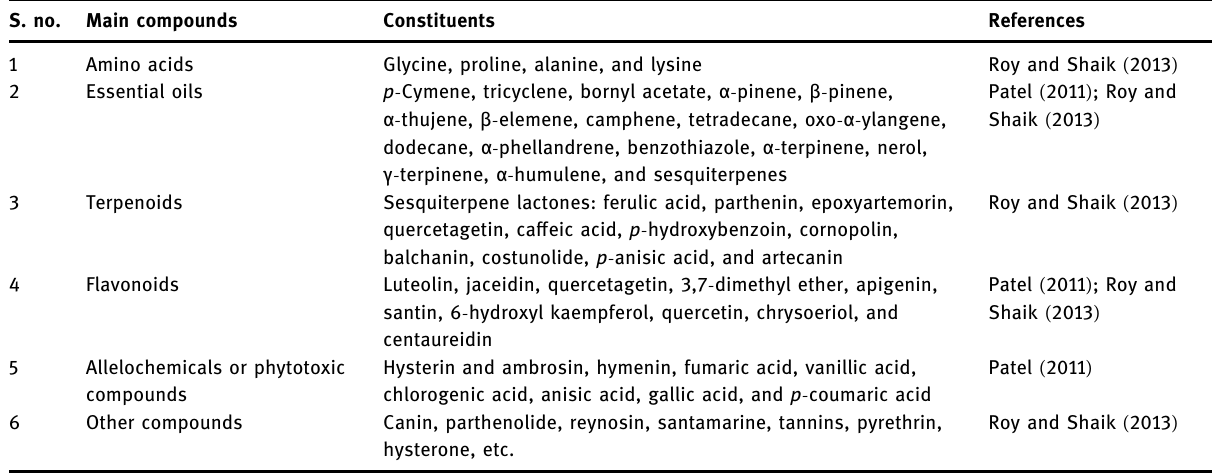
Table 1: Di ff erent chemical constituents of P. hysterophorus